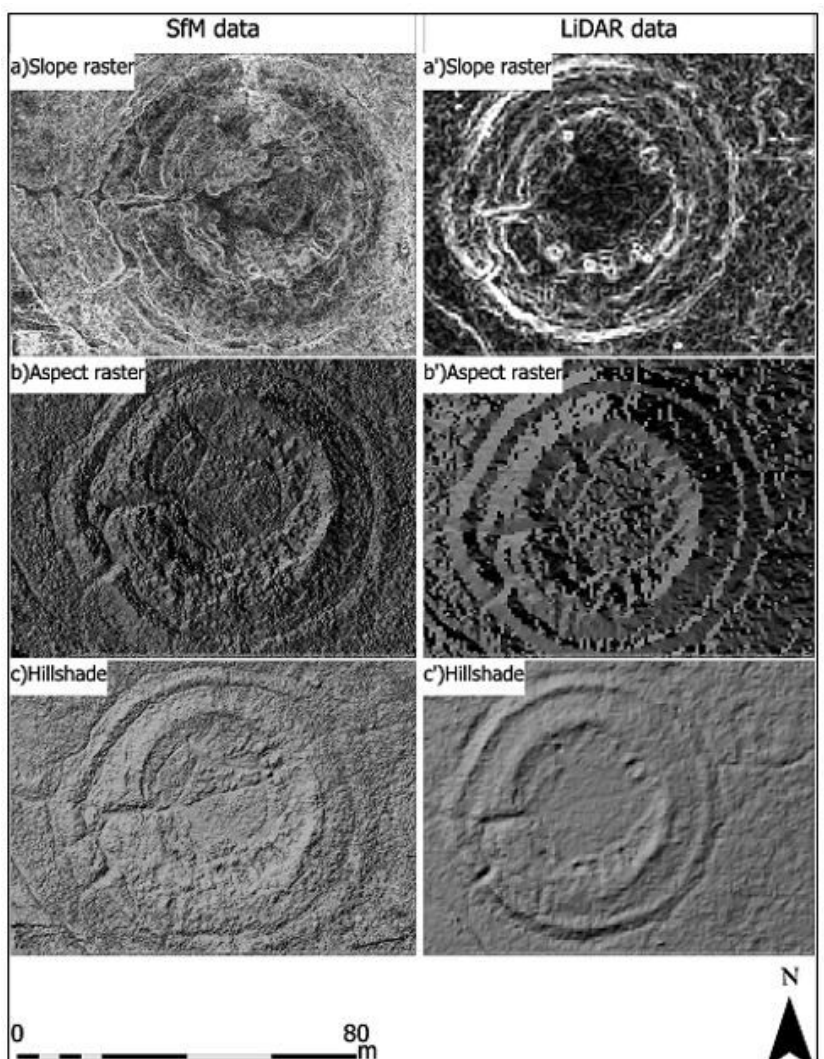
Figure 4. Visualization raster images created from SfM Digital Surface Models (DSMs) ( Left ) and LiDAR DSMs ( Right ) to interpret Chun Castle. The right side shows the raster images derived from Light Detection and Ranging (LiDAR) products. The left side displays the raster images generated from SfM